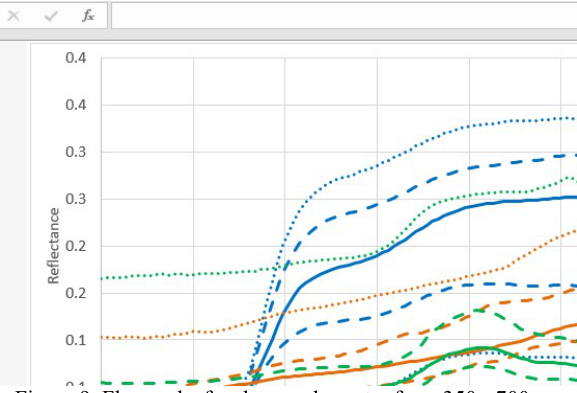
Figure 9. Flower, leaf and ground spectra from 350 - 700 nm A similar process of assessing flower coverage detection was performed on synthetic datasets for other satellite-borne sensors (Figure 10 and Table 4). The results for individual sensor bands correlated with the results of the JM distance analysis, showing that the bands most sensitive to flower detection for all sensors are less sensitive than the MODIS bands with higher JM distances. This correlates with the JM distance analysis of the synthetic data summarised in Table 2.